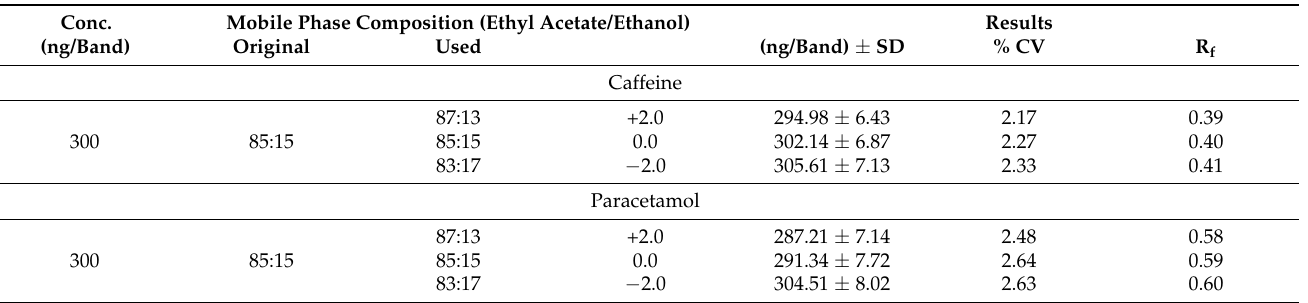
Table 9. Results of robustness analysis of caffeine and paracetamol for the greener normal-phase HPTLC method (mean ± SD; n = 6).